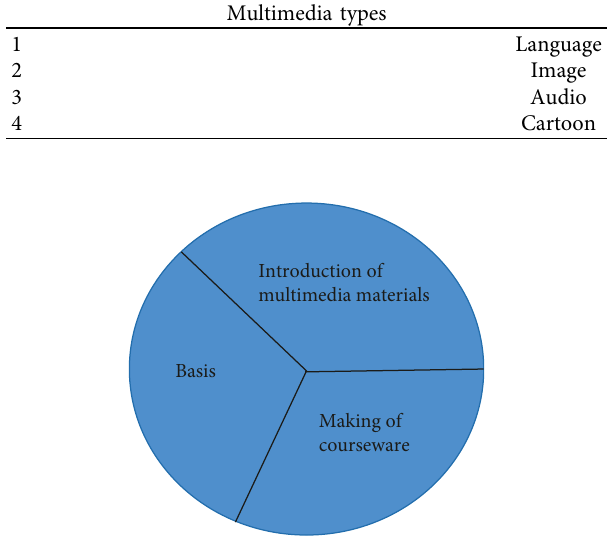
Figure 6: Auxiliary language courseware making